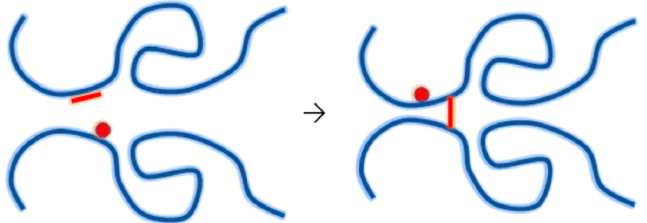
Figure 18. Degradation (chain scission) of a radical-bearing macromolecule.